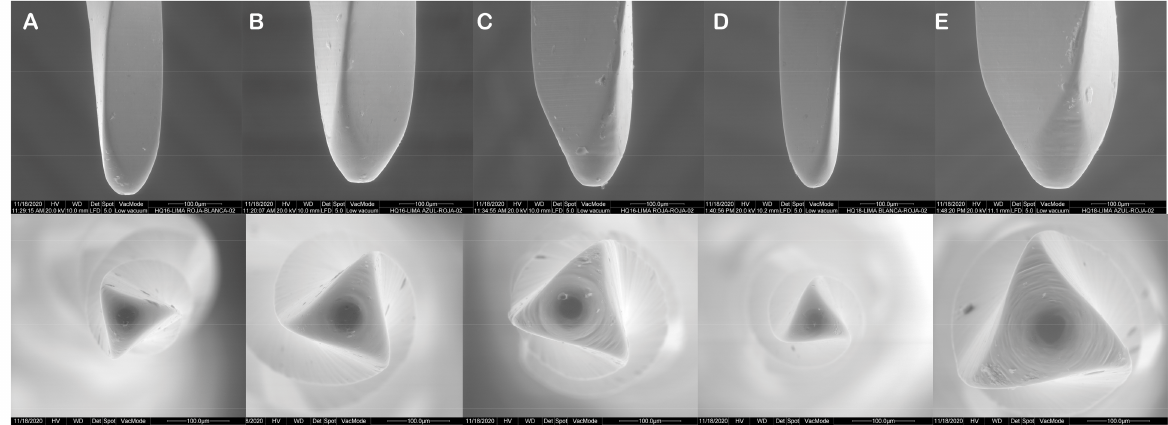
Figure 2. SEM analysis of the apical diameter of ( A ) 25.02, ( B ) 25.04, ( C ) 25.06, ( D ) 20.06, and ( E ) 30.06 NiTi endodontic rotary files.